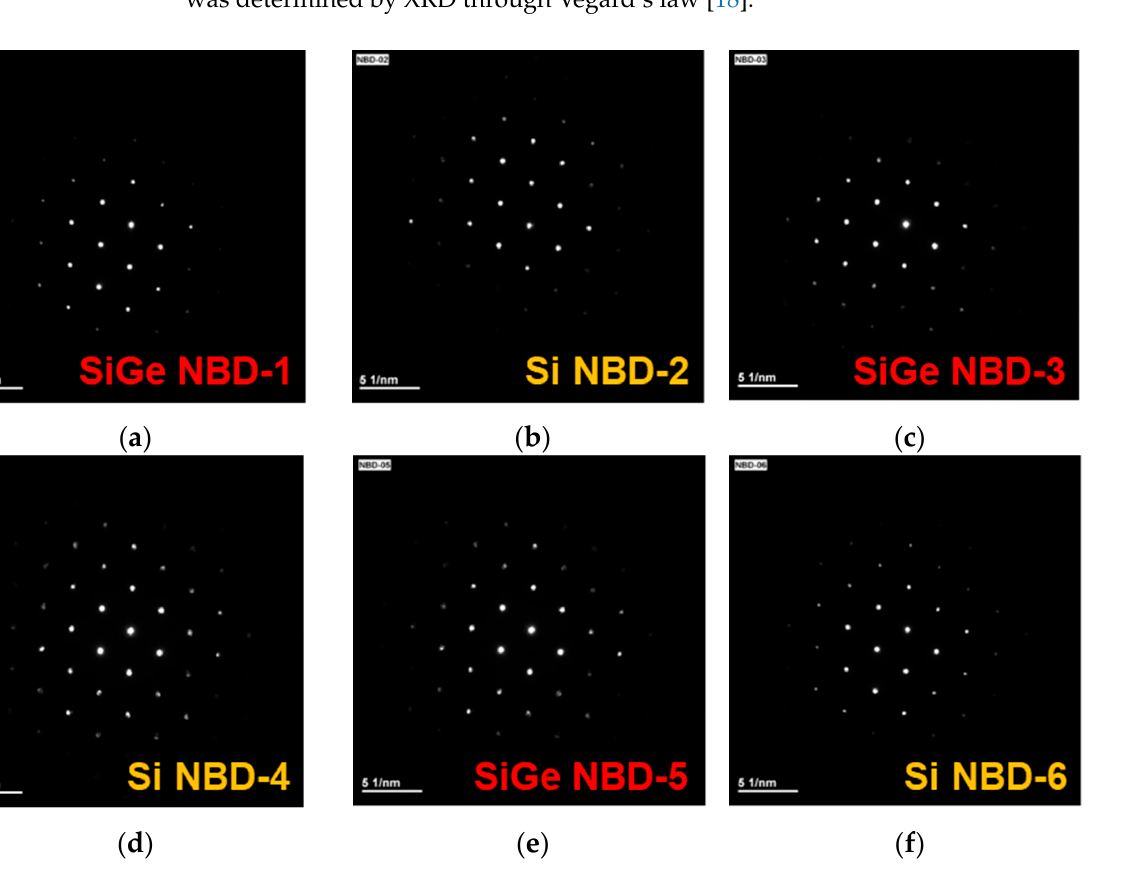
Figure 4. ( a – f ) NBD patterns of Si 0.8 Ge 0.2 /Si SL FinFET from top to bottom layer reveals well epitaxial and single-crystal structure.